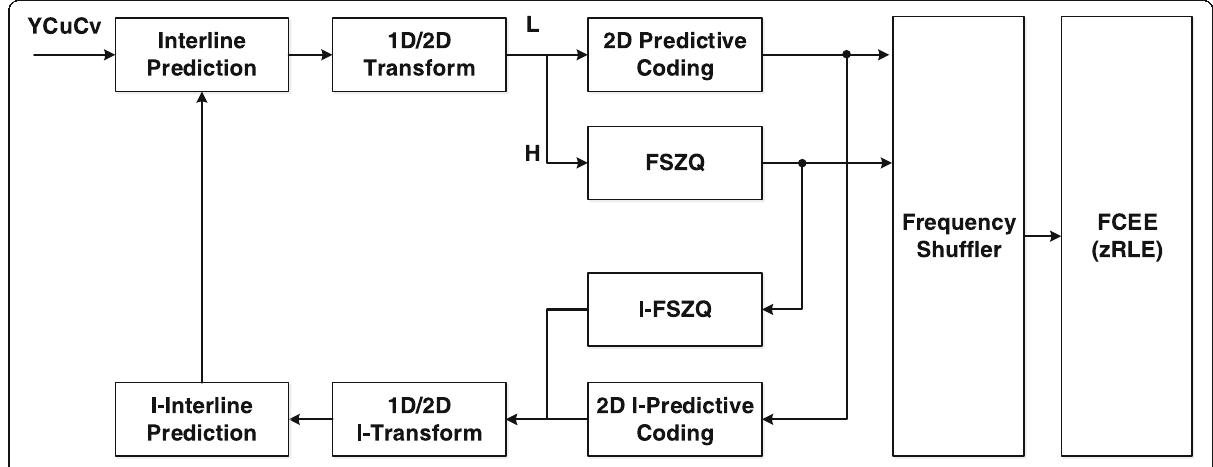
Fig. 4 Proposed 1L/2L selective encoder